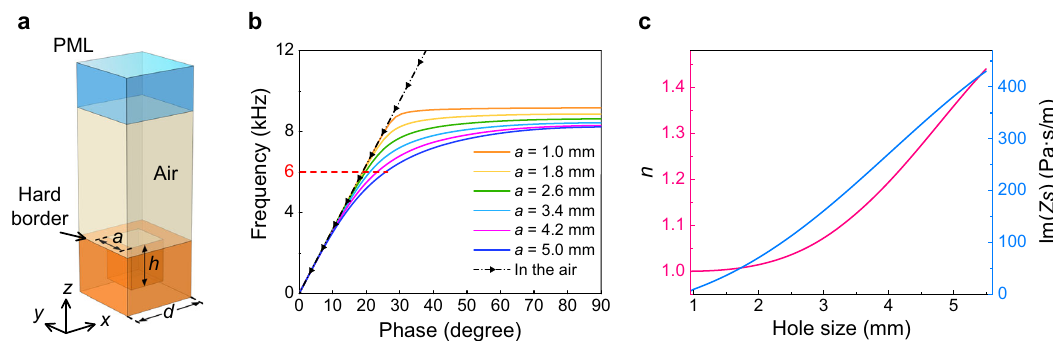
Fig. 2 Building block used for arti fi cial phase modulations. a Basic unit cell: cuboid holes embedded in a solid base are arranged in square lattice, with the period of d = 6 mm, the hole depth of h = 9 mm, and the variable hole size a . b Dispersion curves of unit cells with different hole sizes a , while the black line with triangle marks denotes the air line. c Surface refractive index (pink) and surface impedance (blue) curves with changing hole sizes at